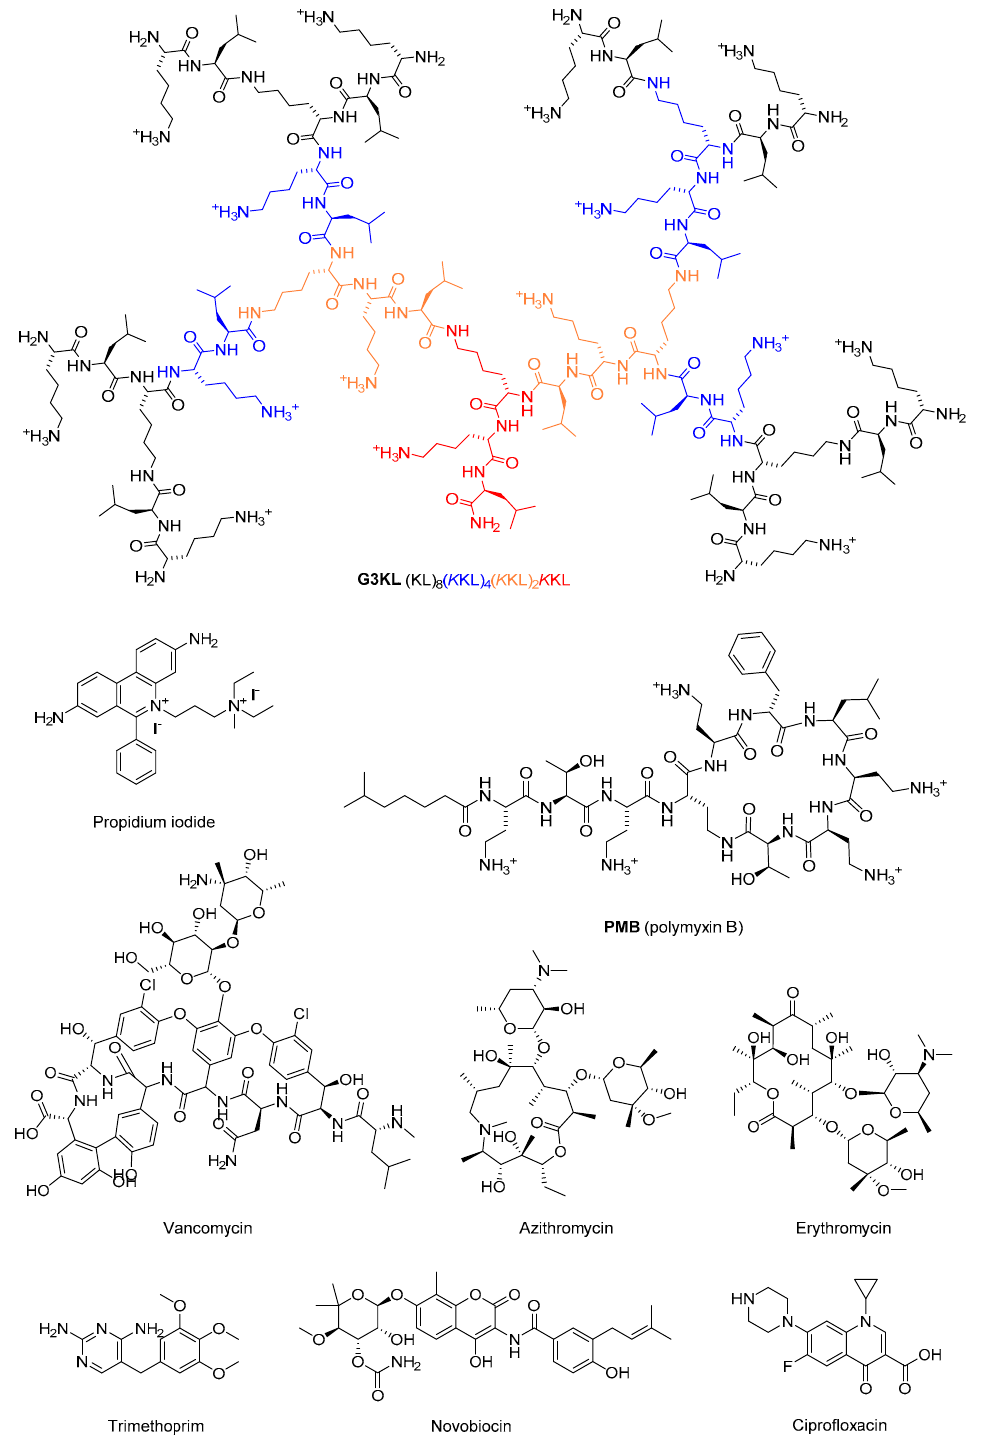
Figure 1. Structural formula of antimicrobial compounds used in this study.